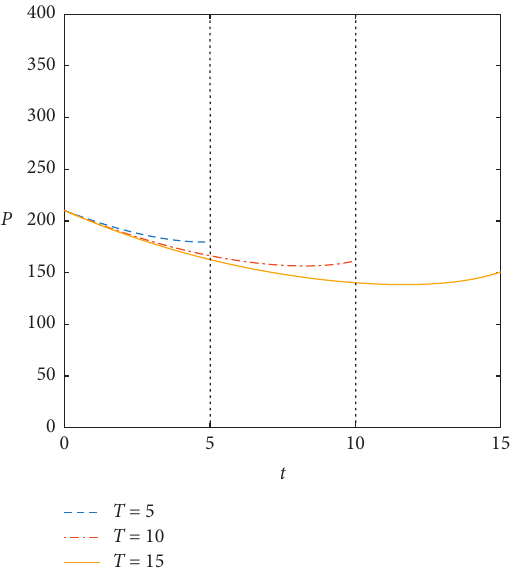
Figure 22: Trajectory curve of optimal pollution stock under cooperation when the planning period T � 5 ,T � 10, and T �